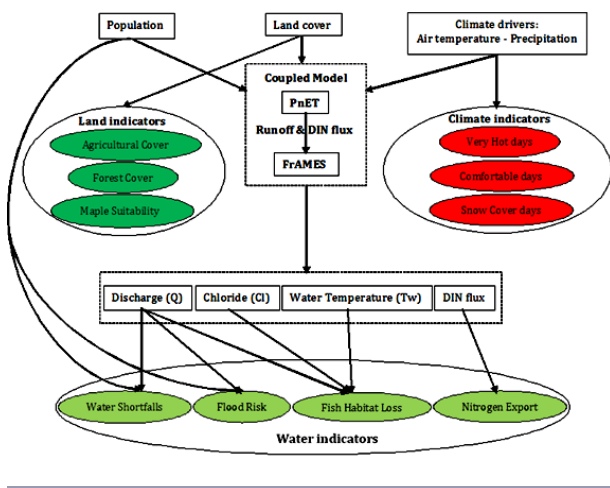
Fig. 2. Conceptual diagram of the terrestrial and aquatic ecosystem model coupling and factors influencing environmental